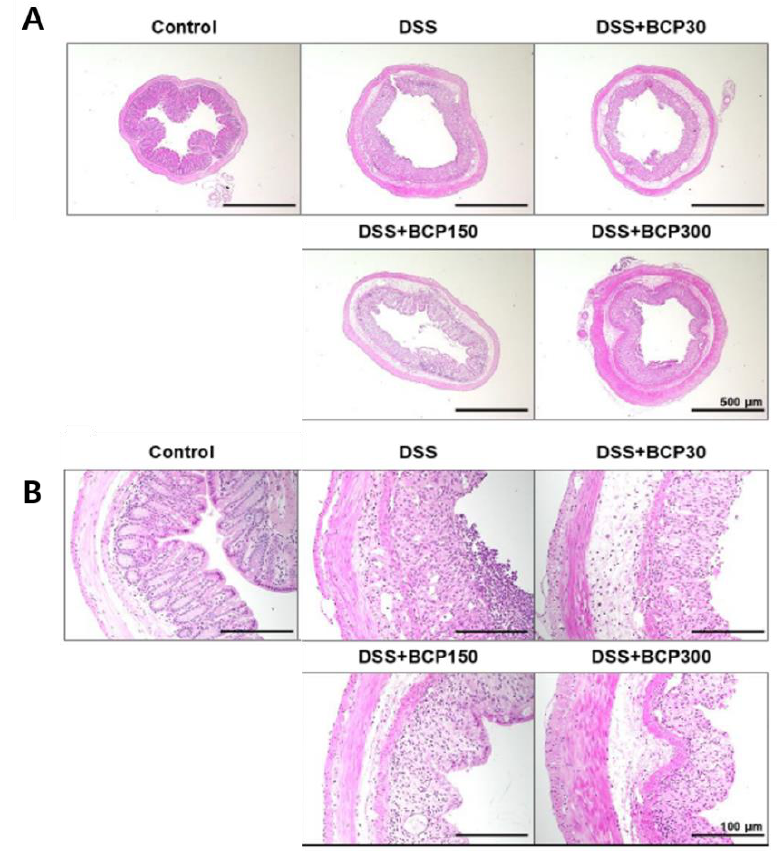
Figure 4. Hematoxylin and eosin staining of mouse colons for evaluating the effect of BCP administration in DSS-induced colitis. The colonic tissure sections were observed at ( A ) 40 × and ( B ) 200 × magnification.